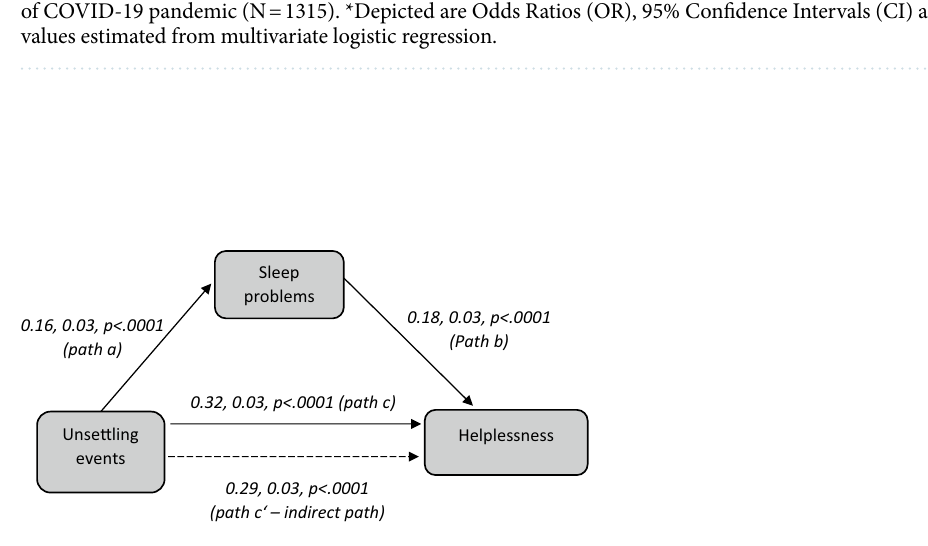
Figure 3. Mediation analysis of sleep problems on the association between unsettling events and helplessness. Graphical representation of the mediation analysis: Path a probes the relationship between unsettling events and sleep problems. Path b probes the relationship between sleep problems and helplessness, while controlling for unsettling events. Path c probes the relationship between unsettling events and helplessness. Path c’ probes the relationship unsettling events and helplessness, while controlling for sleep problems. ß estimates with standard errors and p values from sex-adjusted regression models are reported for each association